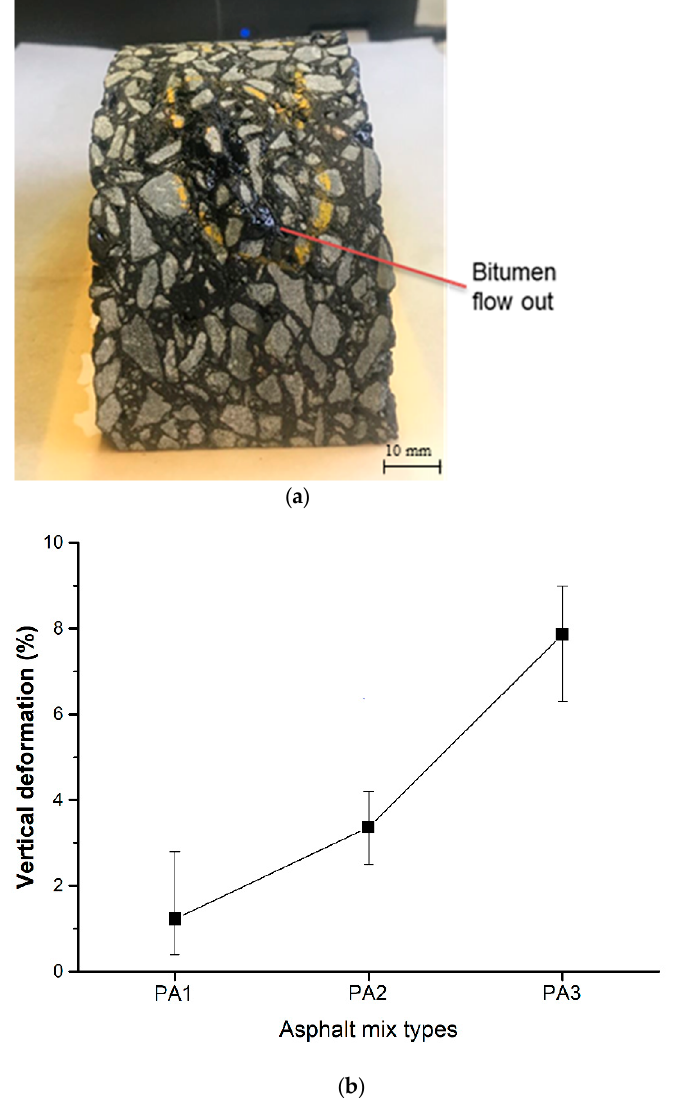
Figure 7. The side effects of microwave heating: ( a ) bitumen flow out and ( b ) the vertical deformation after all testing cycles.